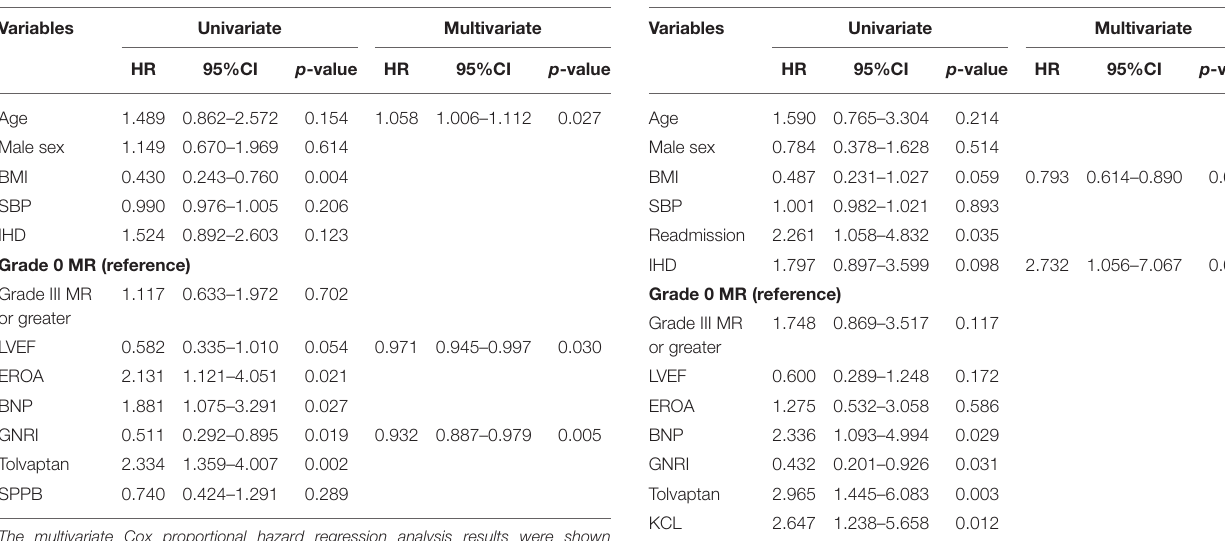
TABLE 3 | The univariate and multivariate Cox proportional hazard regression analyses to predict HF-related endpoint after discharge of patients with ADHF harboring FMR.